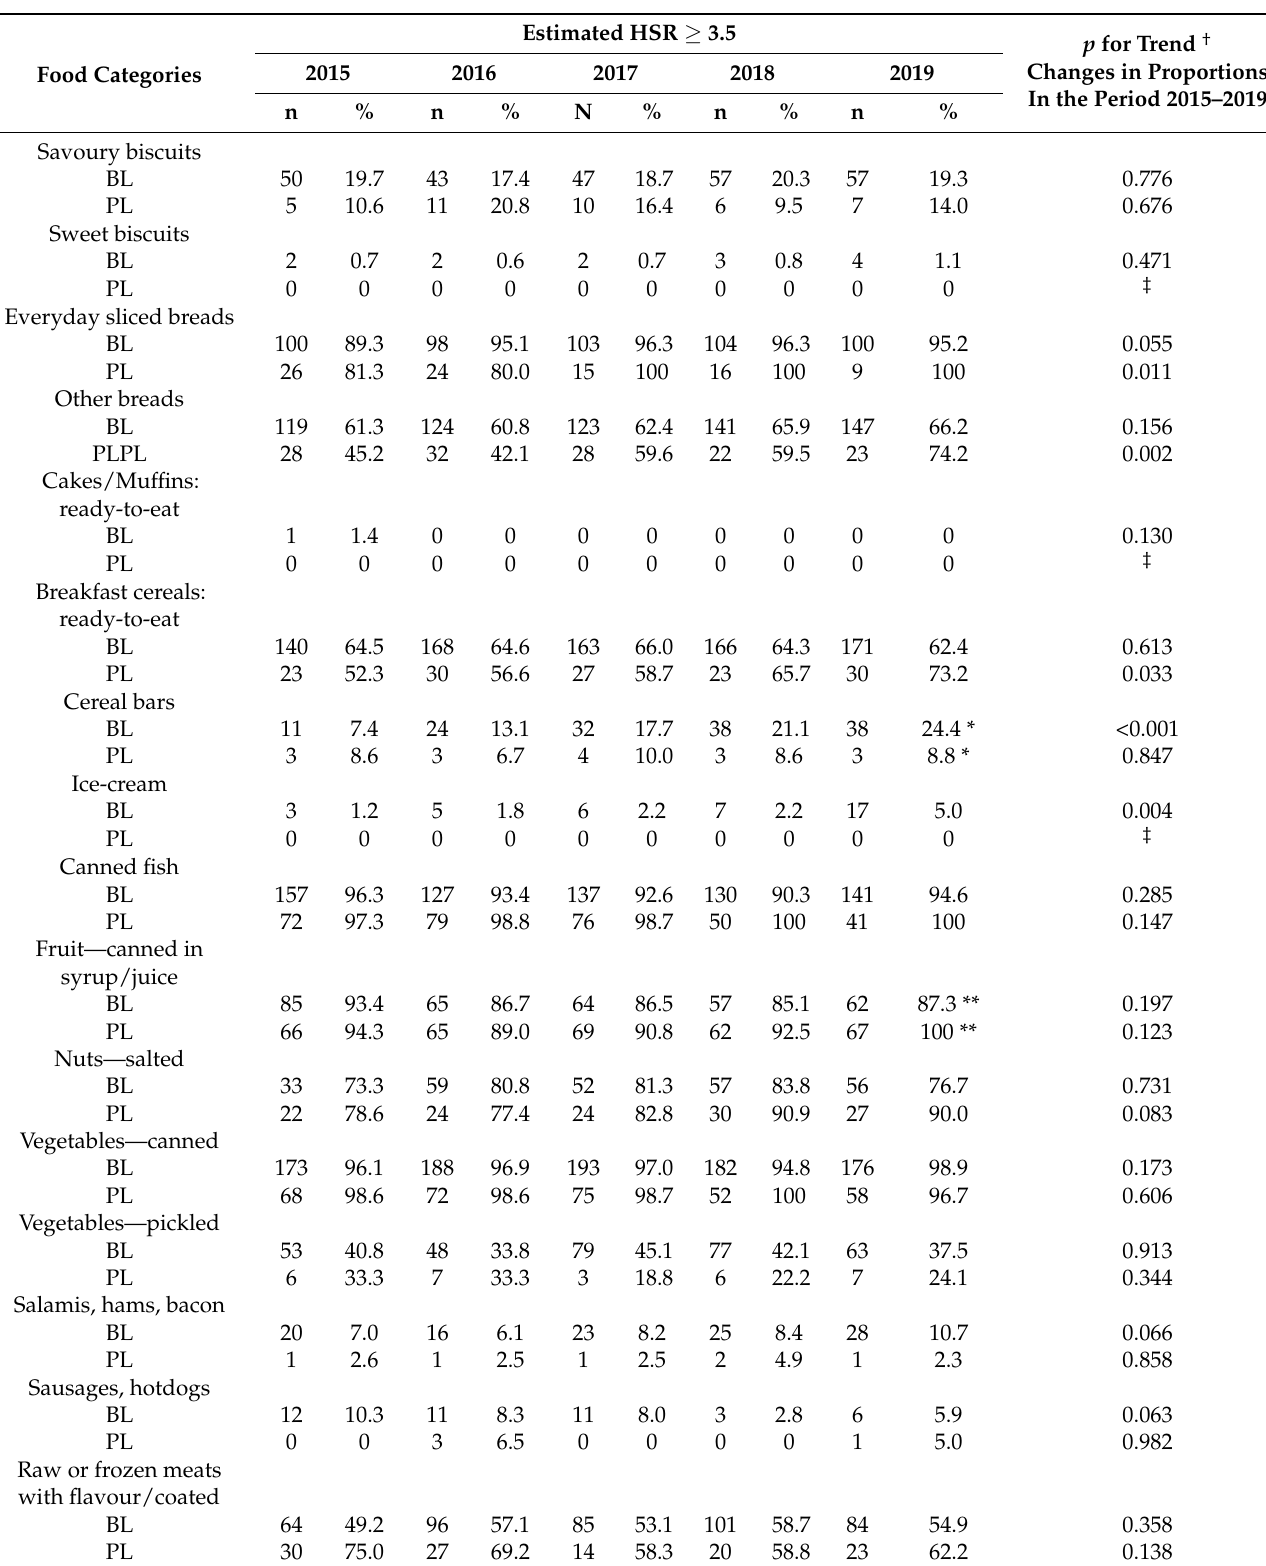
Table 2. Number and proportion of branded and private label products with an estimated HSR of > 3.5 by year (2015–2019), food category and